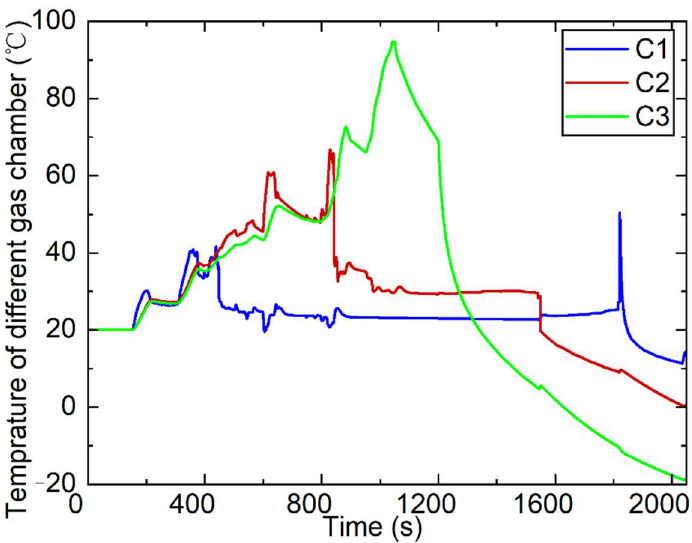
Figure 10. Temperature of different gas chambers.